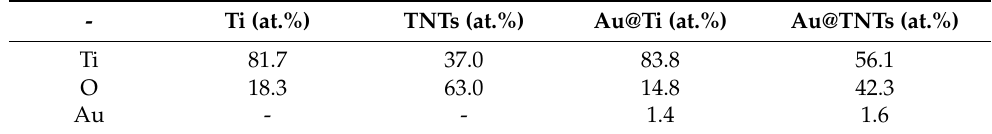
Table 1. Chemical composition of different samples.